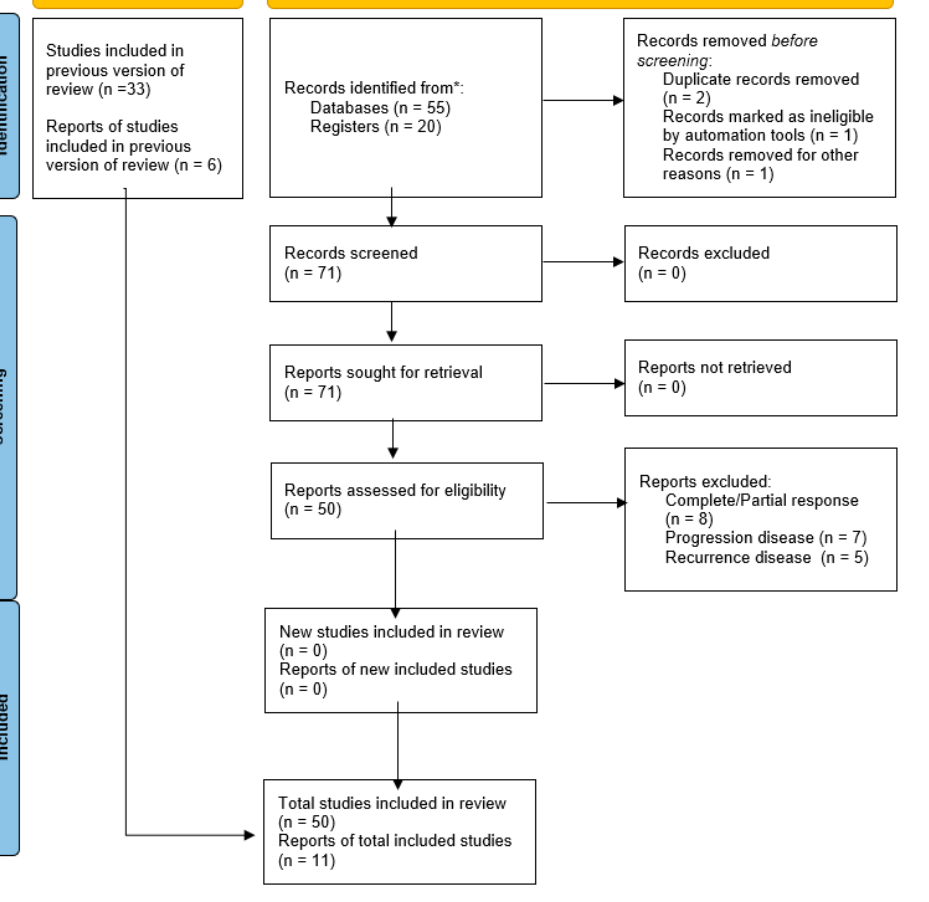
Figure 1. Flowchart of the selection procedure for systematic review. * Consider, if feasible to do so, reporting the number of records identified from each database or register searched (rather than the total number across all